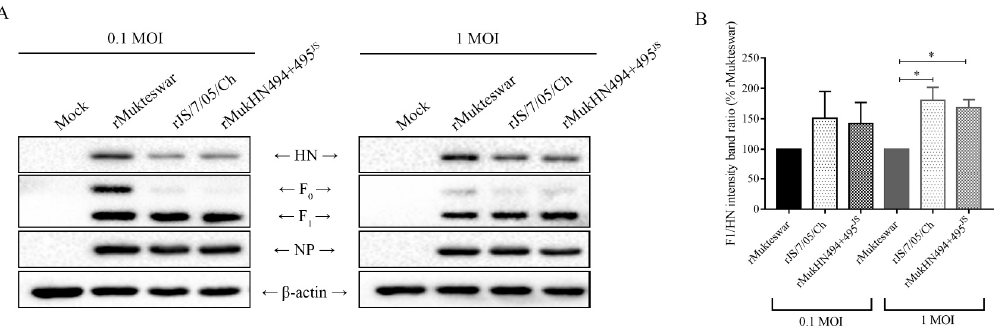
Figure 6. Evaluation of F protein cleavage activities of NDVs bearing different HN proteins. ( A ) Three viruses were inoculated into CEF cells at 0.1 and 1 MOI, respectively. The amounts of HN, F 0 , and F 1 proteins were detected by Western blotting and then the cleavage-promotion activity of different HN proteins was analyzed. ( B ) The gray bands were evaluated by the ImageJ software. The F 1 /HN ratio at each infected group was normalized to that of the rMukteswar group. * p < 0.05.